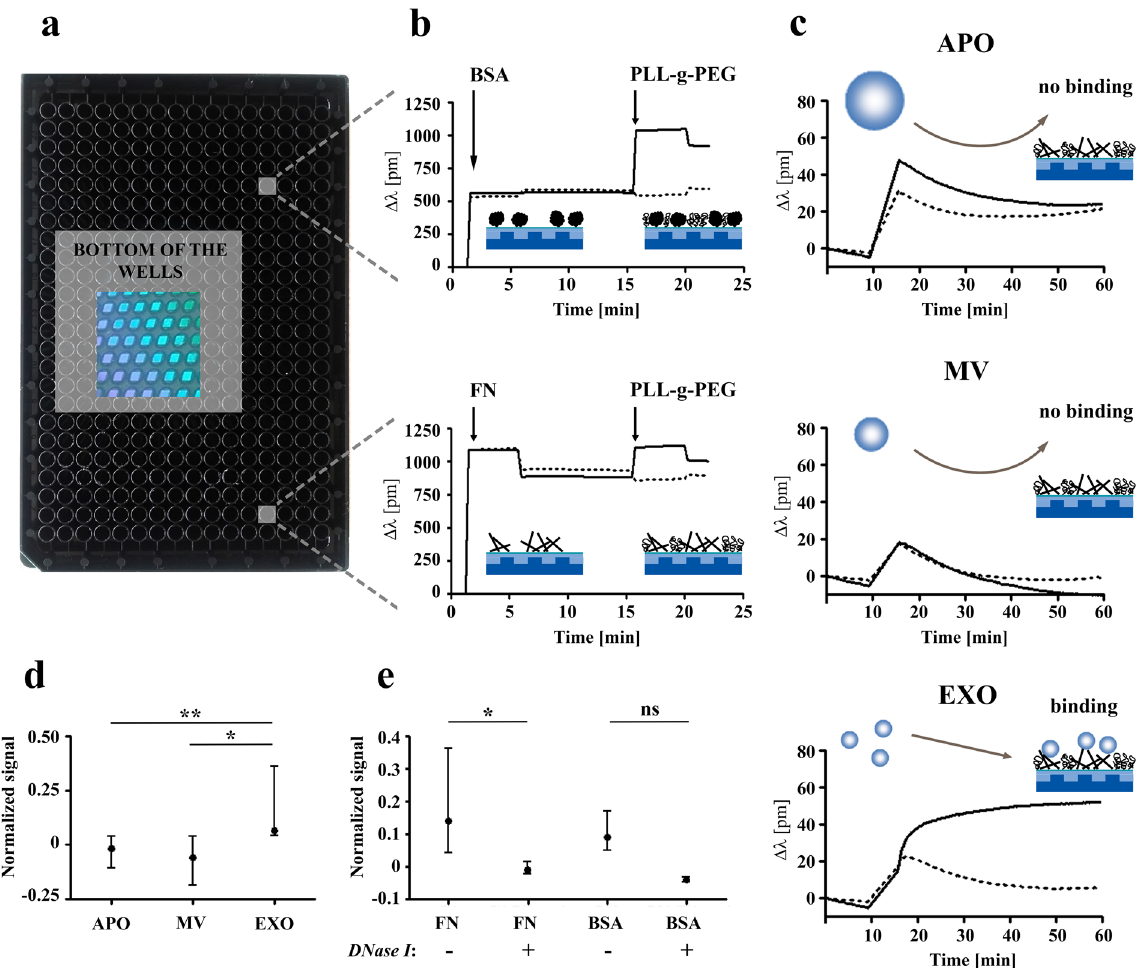
Figure 4. Label-free optical biosensor analysis of surface adhesion of extracellular vesicles (EVs). (a) Photograph of an Epic microplate (384-well) is shown containing biosensors (2 × 2 mm nano-grating embedded in a high-refractive index waveguiding film) at the bottom of each well. Biosensors are imaged from the back of the plate and are visible due to diffraction. (b) Microplate wells were coated with bovine serum albumin (BSA) as a control protein or with fibronectin (FN) resulting in a shift in the resonant wavelength ( Δλ ). Microplate wells were equilibrated with PBS, then BSA or FN were added to the wells (indicated by the first arrows). After one hour incubation with BSA or FN, Δλ was recorded for 5 min. Then, unbound protein was washed out with PBS, and Δλ was measured again for 10 min. Then, PLL-g-PEG was used in order to block the non-specific binding sites of wells. The BSA and FN adsorption signals without addition of PLL-g-PEG (PBS only) are indicated as dashed lines, while adsorption of the blocking PLL-g-PEG in BSA- or FN-coated wells is shown by continuous line. After 30 min incubation with PLL-g-PEG, Δλ was recorded for another 5 min (starting points are indicated by the second arrows), and finally PLL-g-PEG was changed to PBS. (c) Adsorption of apoptotic bodies (APOs), microvesicles (MVs) and exosomes (EXOs) onto FN + PLL-g-PEG surfaces (continuous lines) or onto surfaces with adsorbed PLL-g-PEG only (dashed lines). (d) The Δλ values of EV adsorption onto PLL-g-PEG were subtracted from adsorption values onto FN + PLL-g-PEG, and were divided by the Δλ value of EV adsorption onto bare surfaces (as a straightforward normalization with the mass concentrations of various samples). These normalized signal values are presented as the mean + / − S.D. (error bars) of three independent experiments ( ** P < 0.01 between APOs and EXOs, * P < 0.05 between MVs and EXOs, Mann-Whitney U-test). (e) Comparison of EXO adsorption with/without DNase I digestion onto FN + PLL-g-PEG and onto BSA + PLL-g-PEG surfaces. Normalized signal values are presented as the mean + / − S.D. (error bars) of three independent experiments. Difference was significant in the case of FN surface ( * P < 0.05, Mann Whitney U-test). PLL-g-PEG: poly(L-lysine)- graft -poly(ethylene